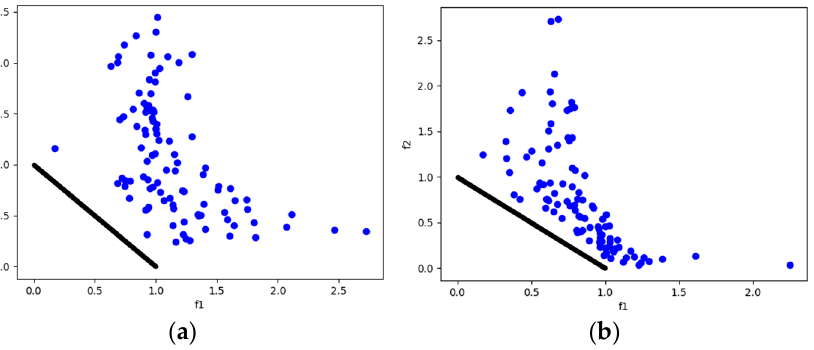
Figure 15. The plots of the approximate PFs with the highest HV value against real PF. ( a ) UF7 approximate PF using MOSA/D-CGO; ( b ) UF7 approximate PF using